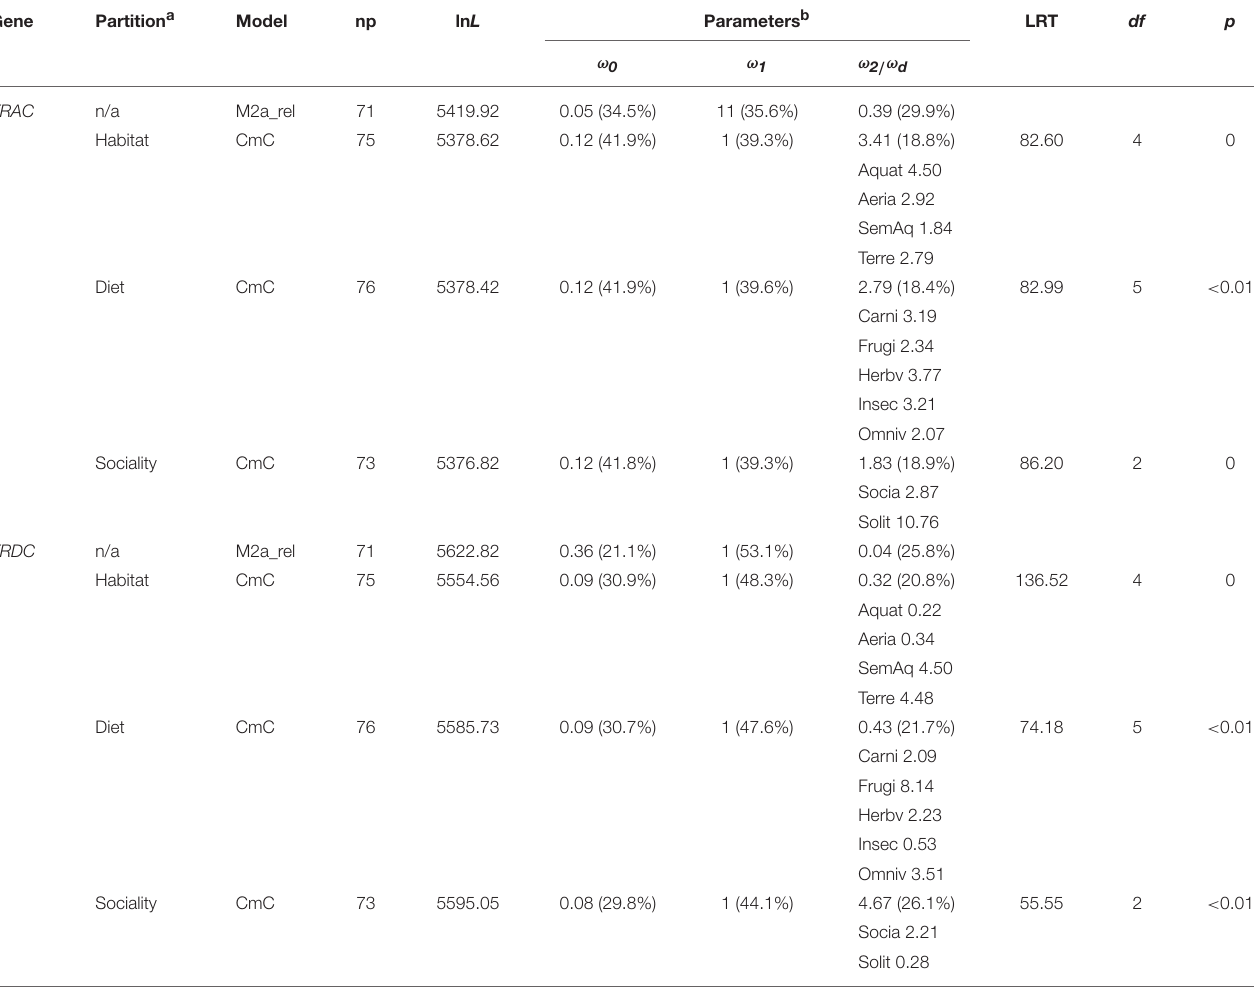
TABLE 3 | Results of clade model C (CmC) analyses on mammalian TRCs.